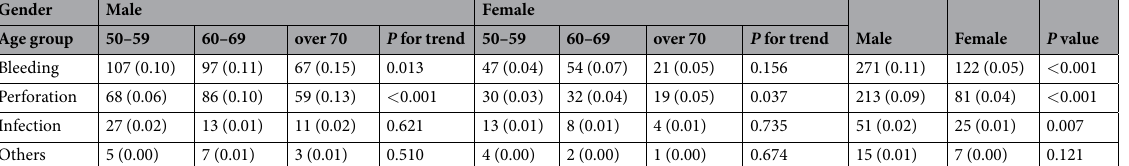
Table 3. Events of side effects occurred within 3 months after colonoscopy according to gender and age group. Values are presented in units of number (%). Corresponding Korean Classification of Diseases (KCD) codes that had been input in the Korean National Health Insurance Service (KNHIS) database within 3 months period after colonoscopy for each category are as follows; bleeding: hemorrhage, and hematoma; perforation: injury, traumatic perforation, and accidental perforation; infection: infection following a procedure; others: air embolism, shock resulting from a procedure, and complications of surgical and medical